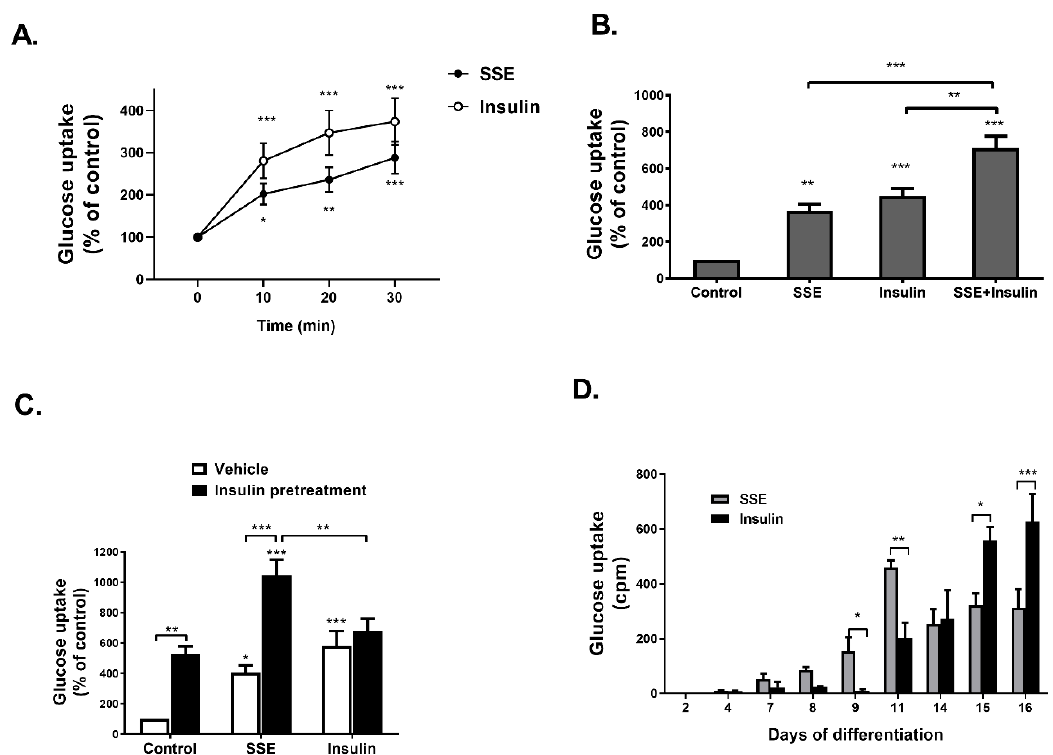
Figure 1. SSE- and insulin-induced glucose uptake in the same time course, with an additive e ff ect. A-C were performed on 3T3-L1 adipocytes at the 14th day of di ff erentiation. ( A ) 3T3-L1 adipocytes were treated with SSE or insulin for the indicated time before measuring glucose uptake. ( B ) 3T3-L1 adipocytes were treated with SSE, insulin or both, for 30 min before measuring glucose uptake. ( C ) 3T3-L1 adipocytes were treated with insulin or vehicle 24 h before treating the cells with either SSE or insulin for additional 30 min before measuring glucose uptake. ( D ) 3T3-L1 at di ff erent days of di ff erentiation were treated with SSE or insulin for 30 min before measuring glucose uptake. In all experiments ( A – D ), the uptake of [3H]2-Deoxy-D-glucose into cells was determined as described in Material and Methods. The data represent the mean ± SEM of measurement made on six replicates in each of at least five independent experiments. * p < 0.05, ** p < 0.005, and *** p < 0.0005 compared to untreated cells by Student’s t -test ( A ) or analyzed by one-way ANOVA, followed by Bonferroni’s post-hoc testing ( B – D ).